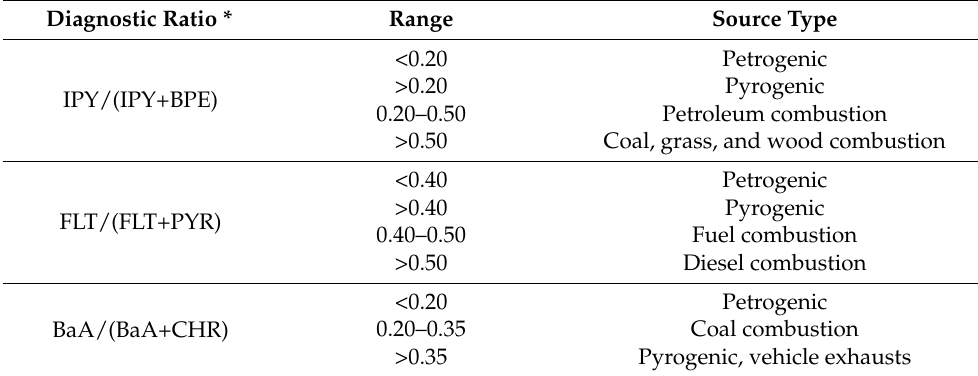
Table 4. Diagnostic ratio ranges for PAH from different source types. Diagnostic Ratio